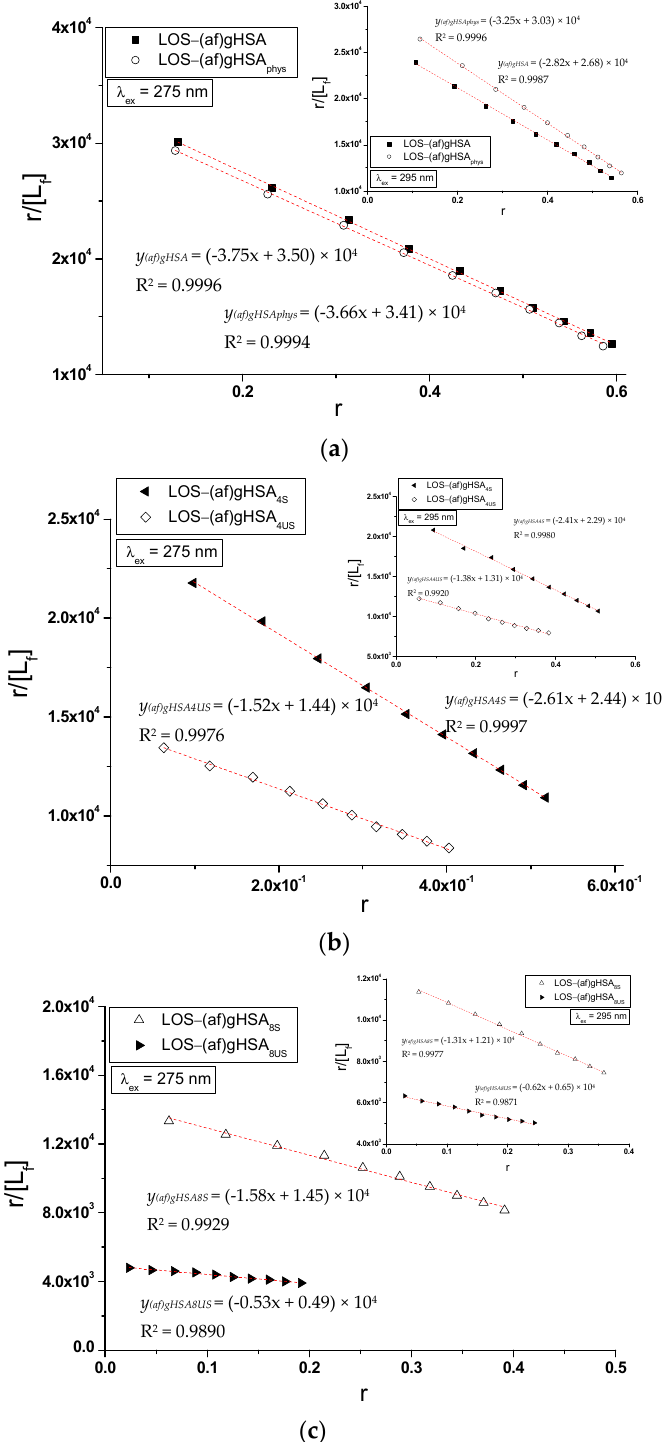
Figure 7. The Scatchard curves of r/[L f ] vs. r for ( a ) LOS-(af)gHSA and LOS-(af)gHSA phys , ( b ) LOS-(af)gHSA 4S and LOS-(af)gHSA 4US , and ( c ) LOS-(af)gHSA 8S and LOS-(af)gHSA 8US systems, λ ex = 275 nm (in the main view), λ ex = 295 nm (in the insert); the error bars are smaller than the symbols.